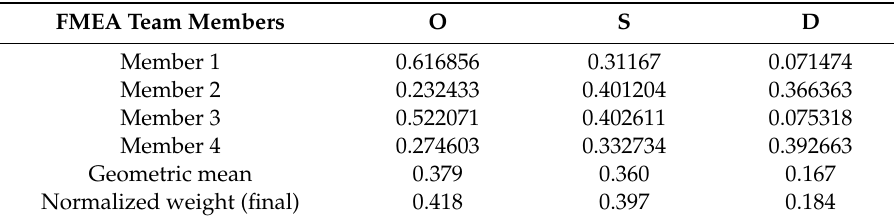
Table 4. Final weights of risk factors.